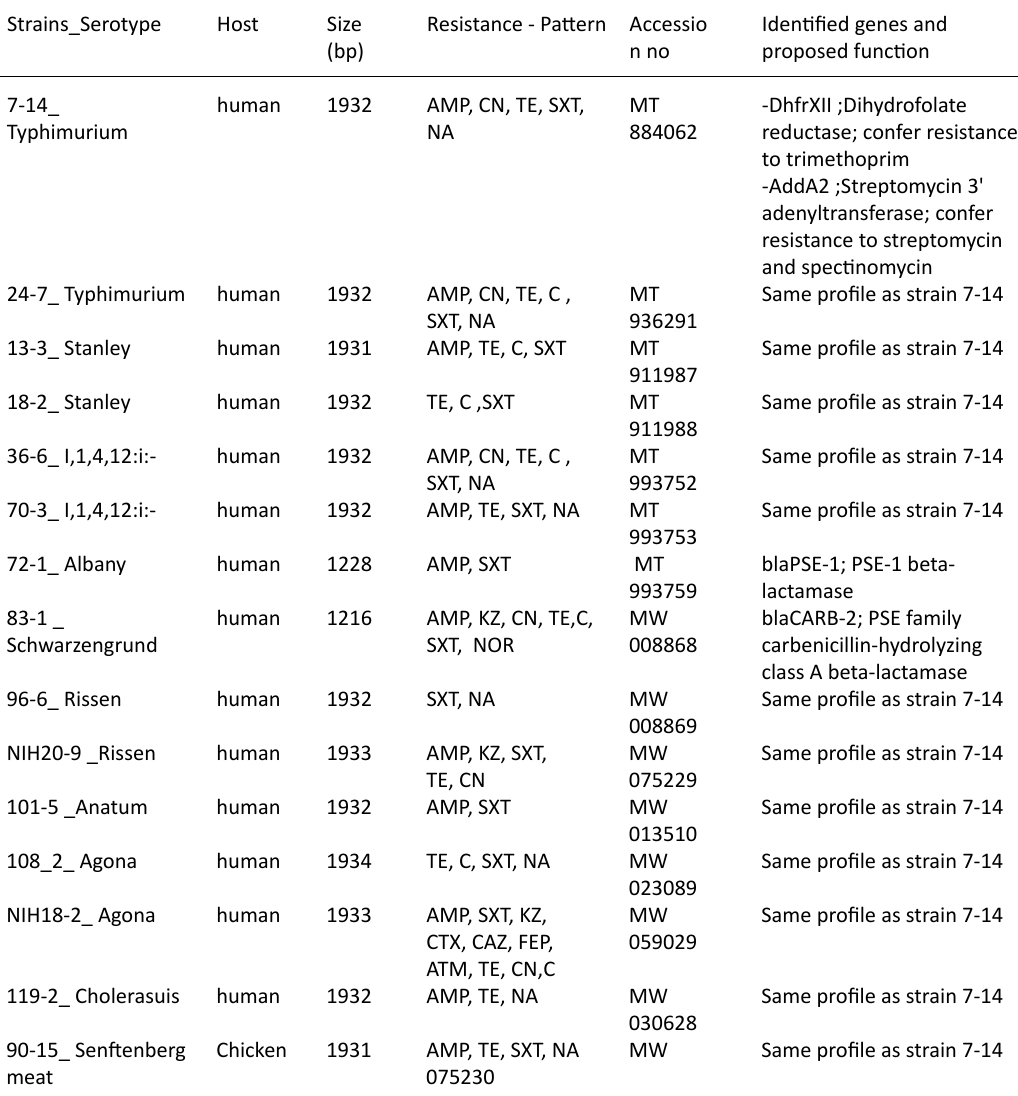
Table 6. Gene cassettes associated with integron 1 found in plasmids of Salmonella Enterica, isolated from human and chicken meat